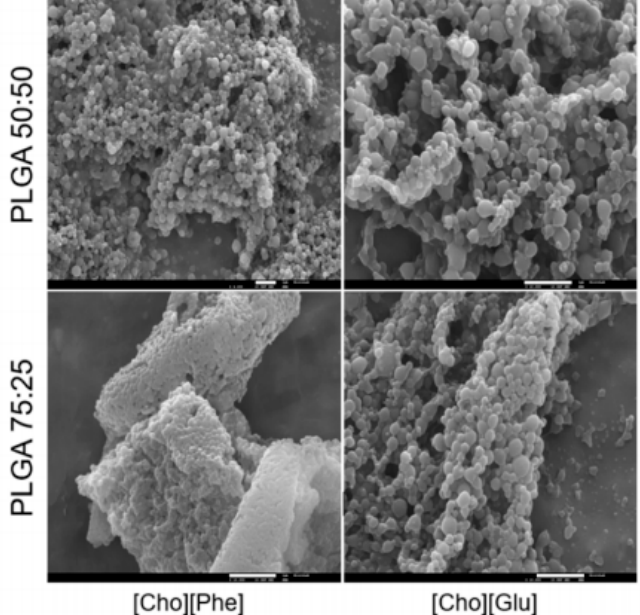
Figure 6. SEM micrographs of rutin-loaded IL-polymer nanoparticle hybrid systems after freeze drying at a magnification of 4000 × (PLGA 50:50/[Cho][Phe] and 10,000 × (remaining images). The scale bar of the micrographs at the bottom right of the images corresponds to 2 µm. Reprinted with permission from [114].